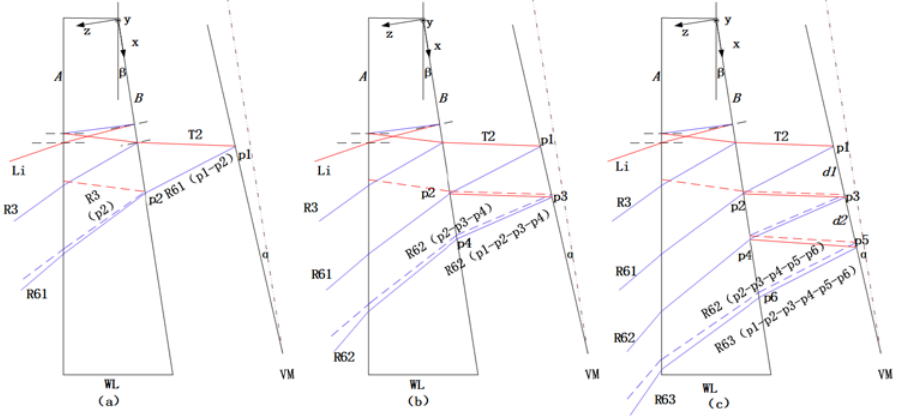
Figure 3. ( a ) Interference between R61 and R3; ( b ) interference between R61 and R62; and ( c ) interference between R62 and R63